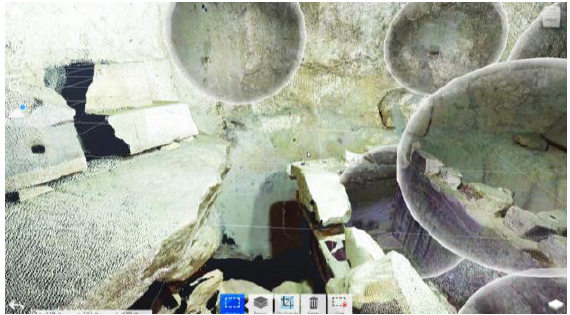
Figure 7: Position of the scanned and result of the scanner. Point cloud, 2018.